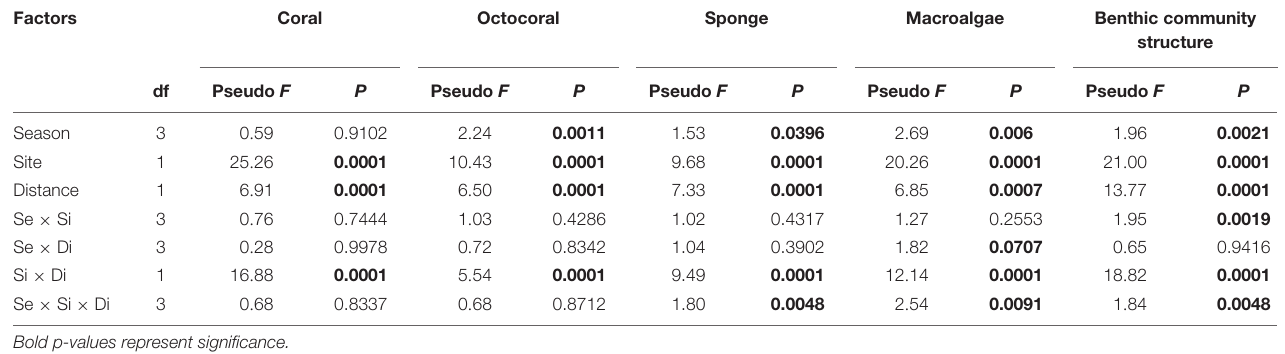
TABLE 2 | Results of permutational analysis of variance (PERMANOVA) for benthic components by factors. Factors Coral Octocoral Sponge Macroalgae Benthic community df Pseudo F P Pseudo F P Pseudo F P Pseudo F P Pseudo F P